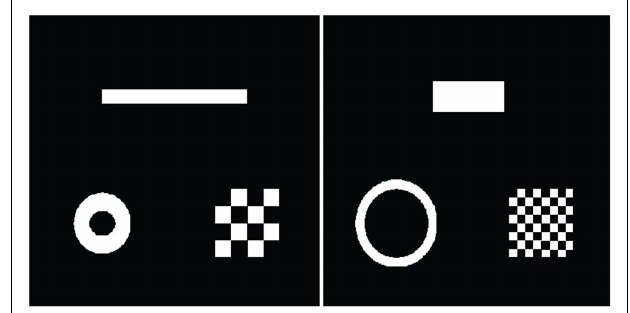
FIGURE 3 | “One-away” stimuli for Phase III of the experiment, the generalization